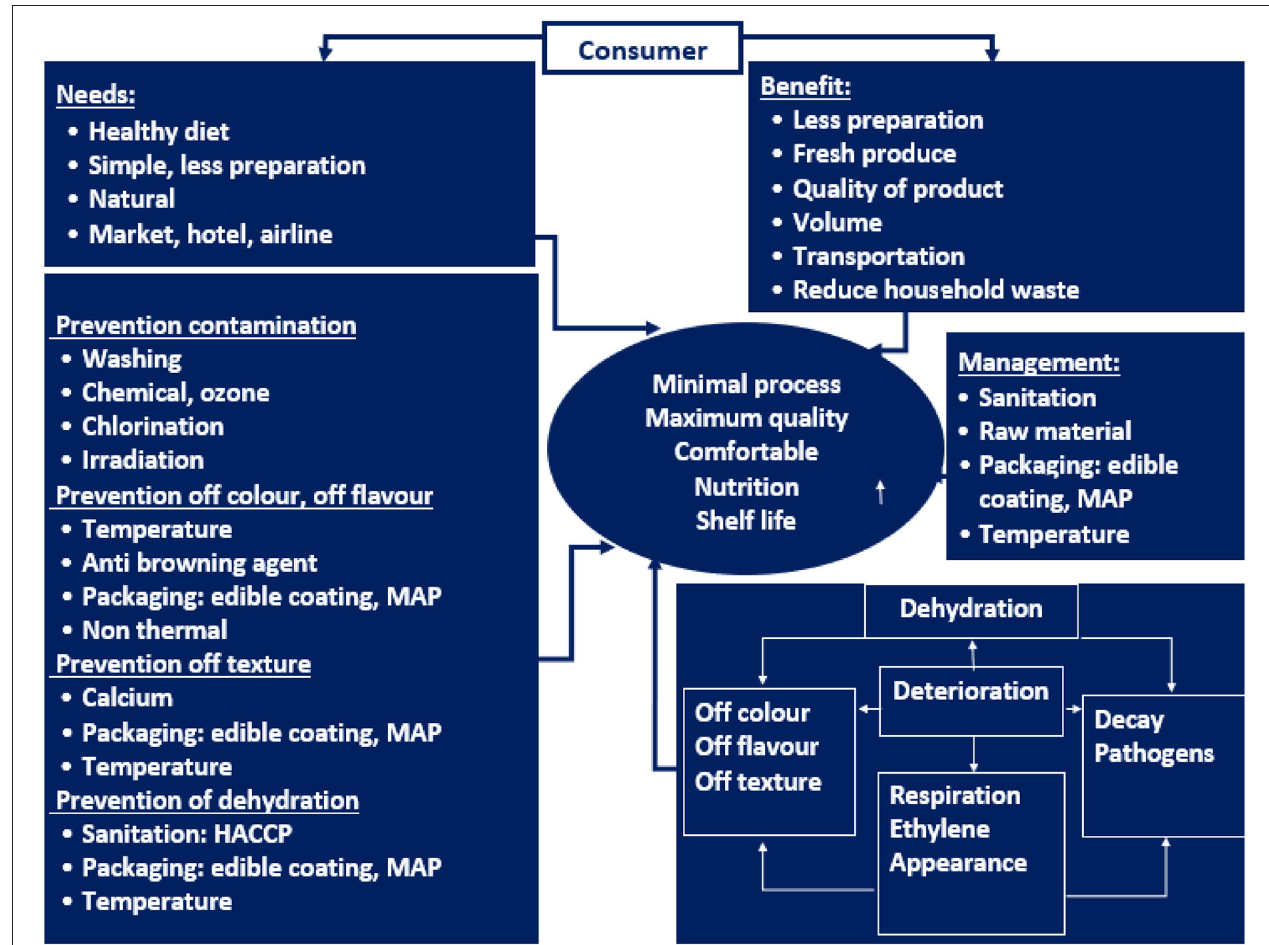
FIGURE 2 | Fresh-cut fruit